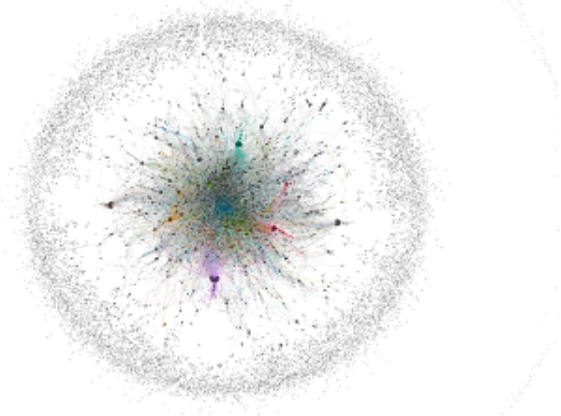
Figure 1. Network Topology of Crowdfunding